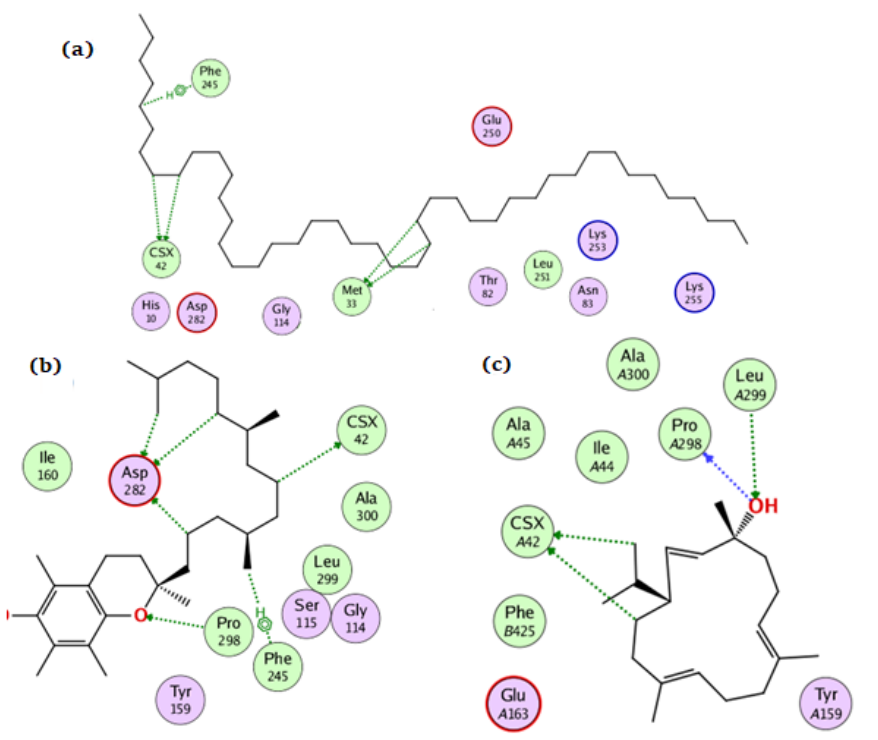
Figure 4. The docking of ( a ) tetratetracontane, ( b ) α -tocopherol, and ( c ) thunbergol on the active site of NADPH oxidase enzyme (PDB code: 2cdu).